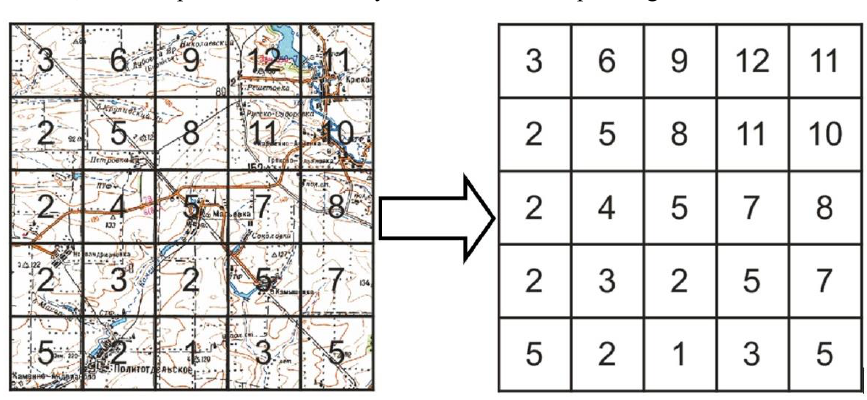
Fig. 3. The cross-country rate